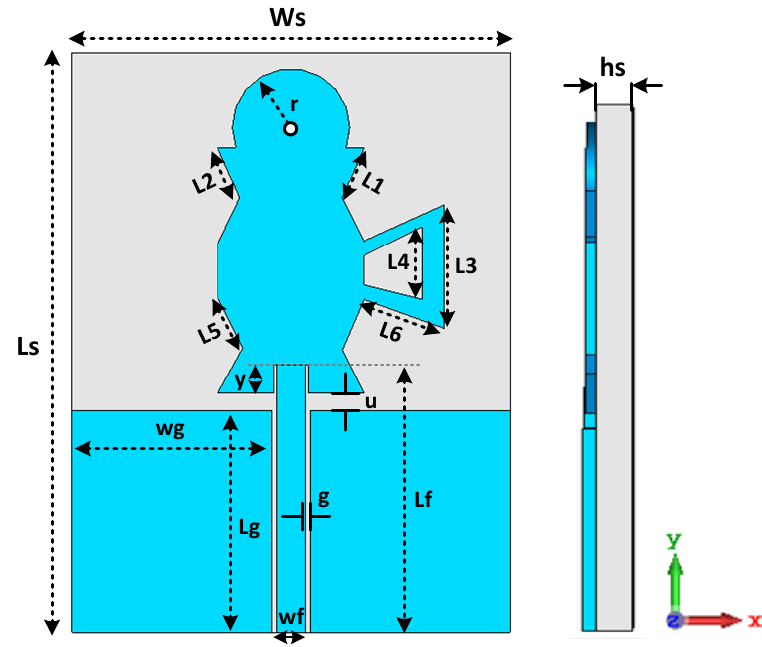
Figure 1. Schematic diagram of the presented UWB antenna.